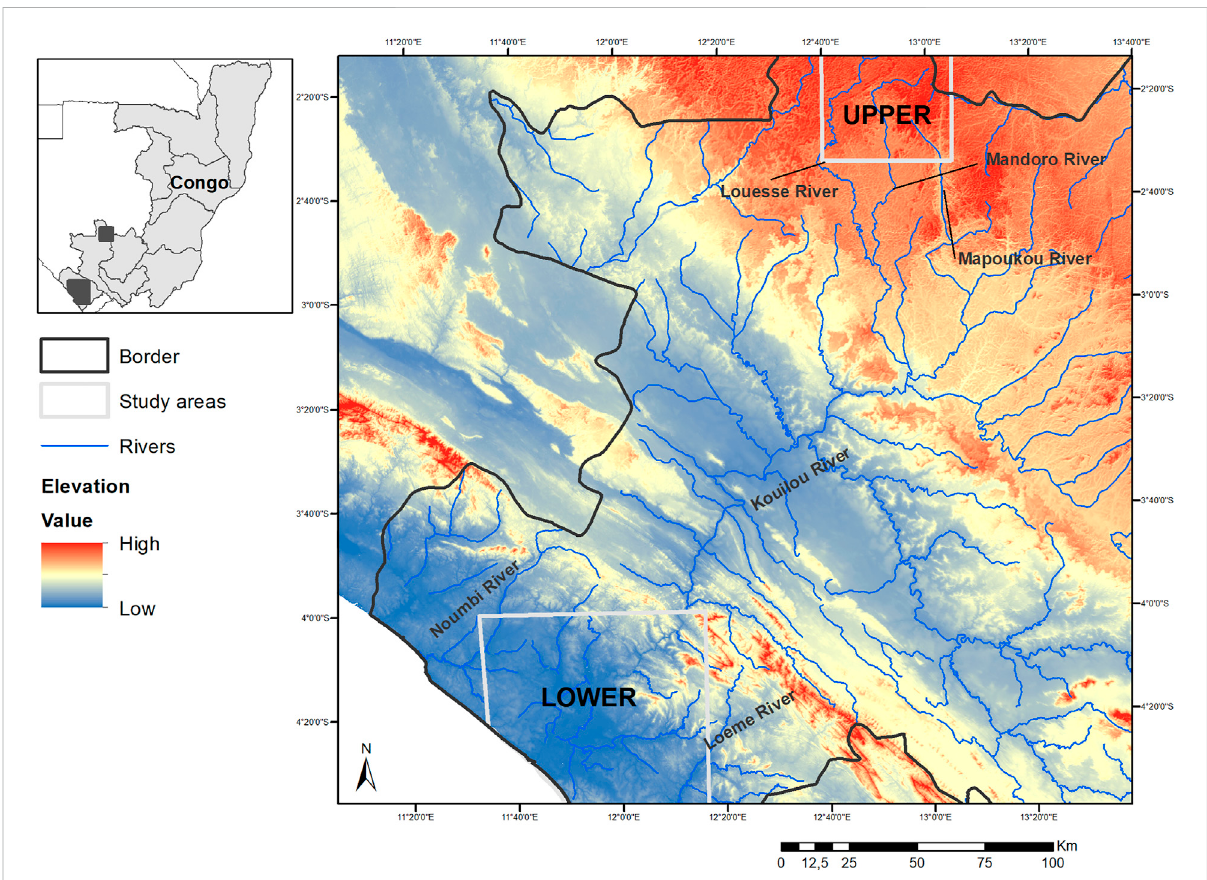
FIGURE 1 UpperandlowerbasinstudyareasintheKouilou,LoéméandNoumbibasinsintheRepublicofCongo showingmajordrainagesandelevations. The highest point regionally is approximately 750 m above sea